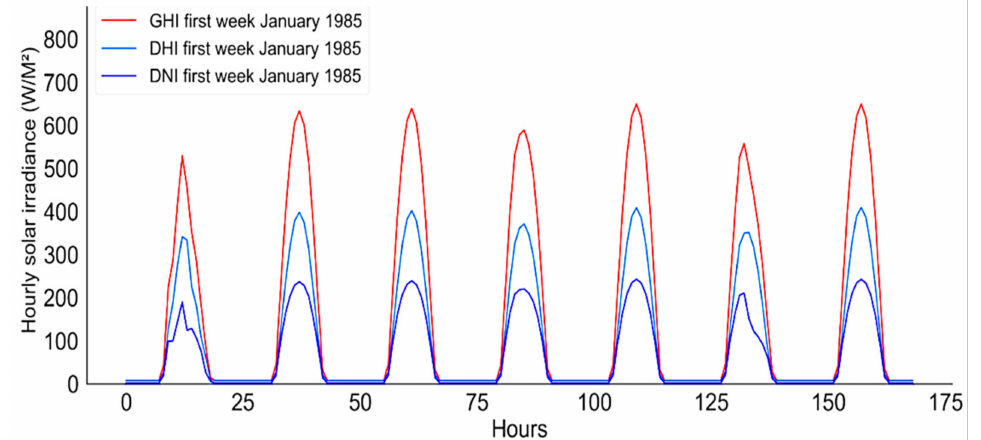
Figure 11. Hourly intervals historical performances of the GHI, DHI, and DNI.